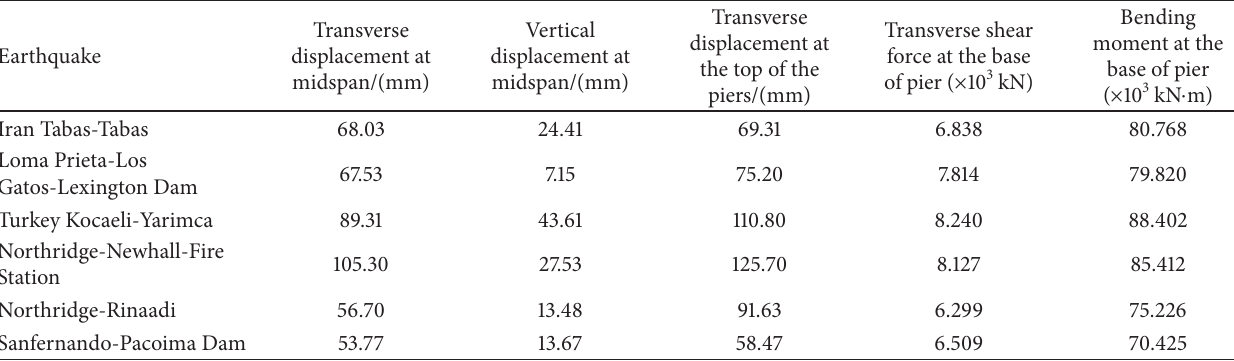
Table 9: Seismic response of high-speed railway bridge with 350 km/h vehicle speed and pier height 14m under high-level near-fault earthquake action.